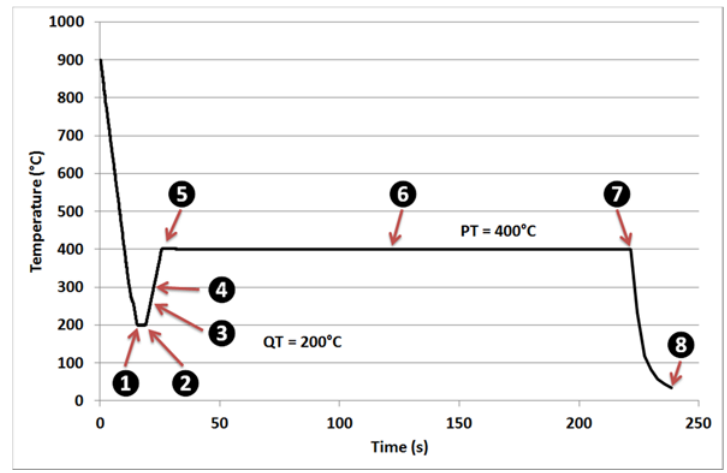
Figure 1. Quenching and Partitioning (Q&P) thermal treatment applied on the studied steel after a 5 min austenitization at 900 °C. The experiment was carried out in situ on a synchrotron beamline. 2D diffraction patterns were acquired every 0.1 s all along this cycle. Eight points of interest are highlighted.